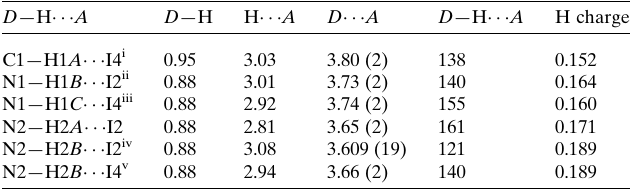
Table 1 Hydrogen-bond geometry (A˚ , (cid:4) ) and calculated charges for the specified hydrogen atom derived according to the Mulliken scheme.